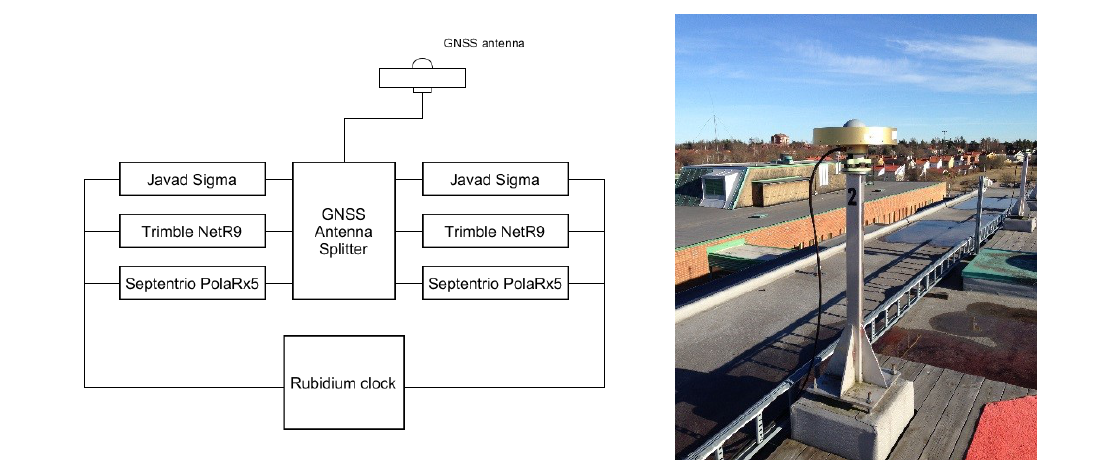
Figure 1: Zero-baseline setup at the main site in Gävle